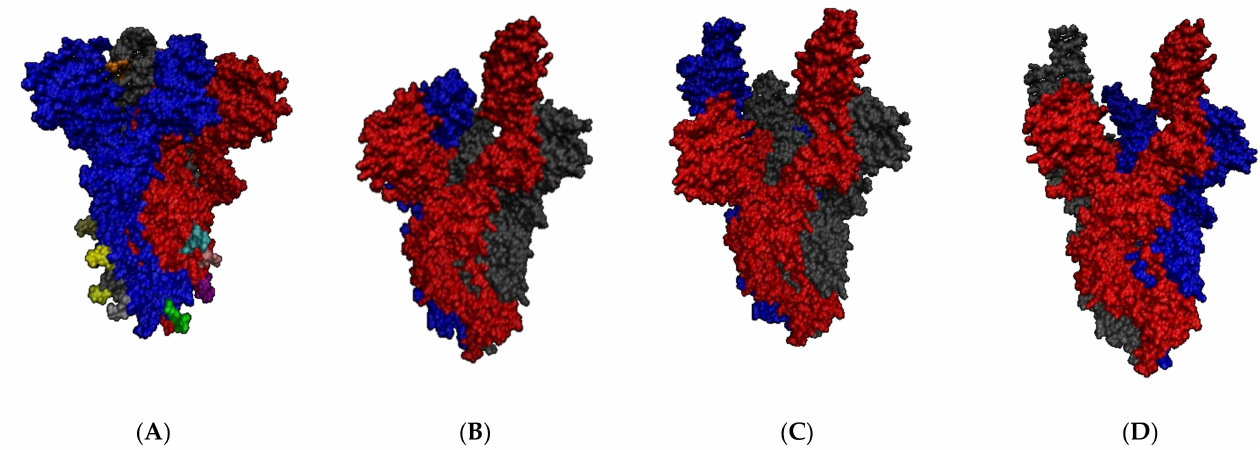
Figure 3. Spike protein conformations, with each spike monomer is represented by a colour (blue, red, gray). ( A ) All RBD down (PBD 6VVX) ( B ) 1 RBD up (PDB 7A94) ( C ) 2 RBD up (PDB 7A97) ( D ) All RBD up (PDB 7A98)